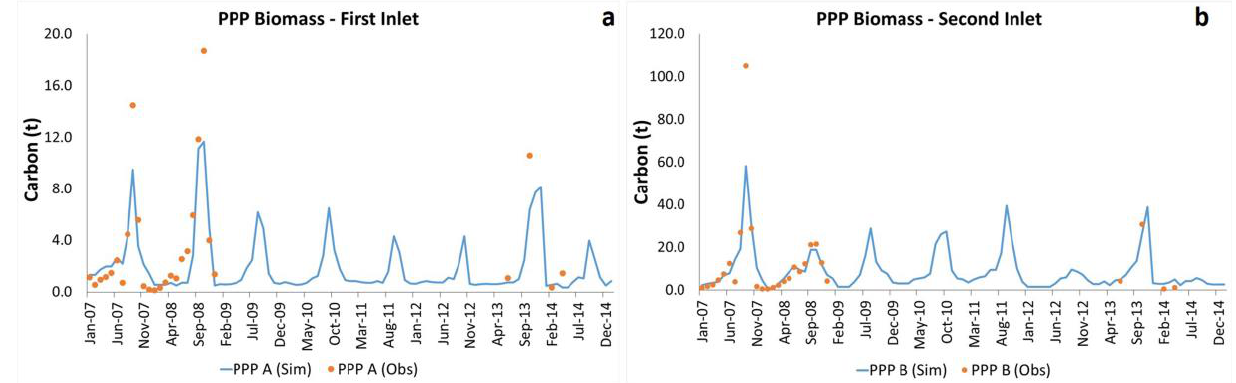
Figure 6. Pico-Phytoplankton (PPP) biomass (t of Carbon) simulated (line) and field data (dots) in the First Inlet ( a ) and in the Second Inlet ( b ) of Mar Piccolo.